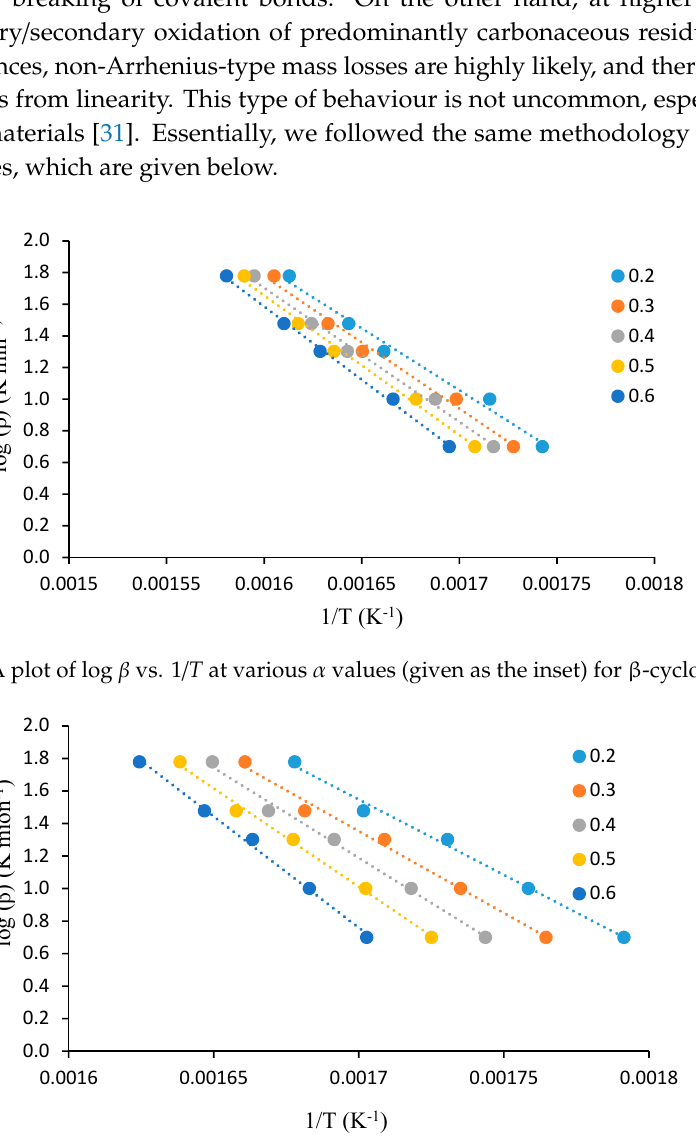
Figure 2. A plot of log β vs. 1/ T at various α values (given as the inset) for dextran.